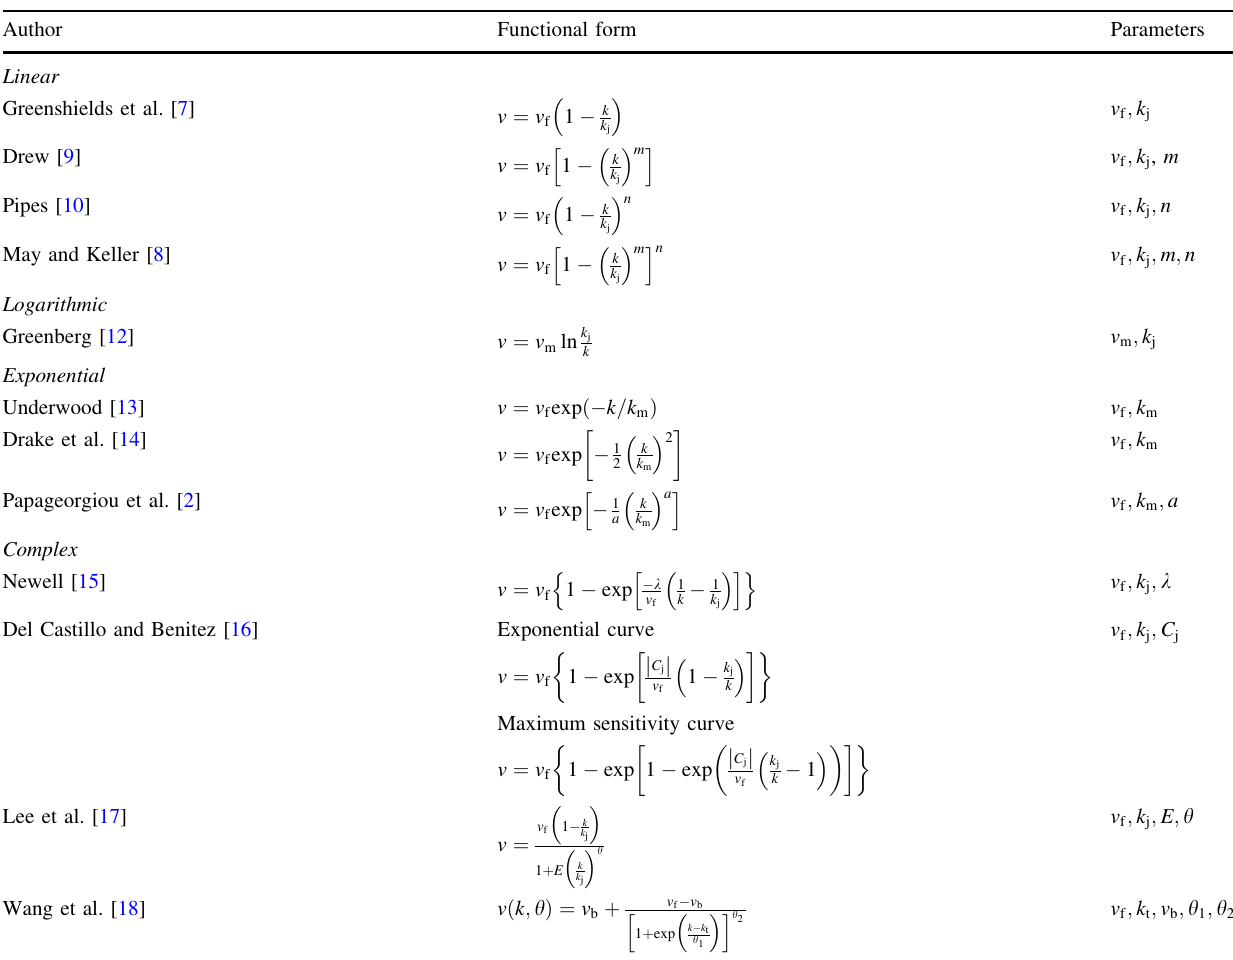
Table 1 Speed–density functional